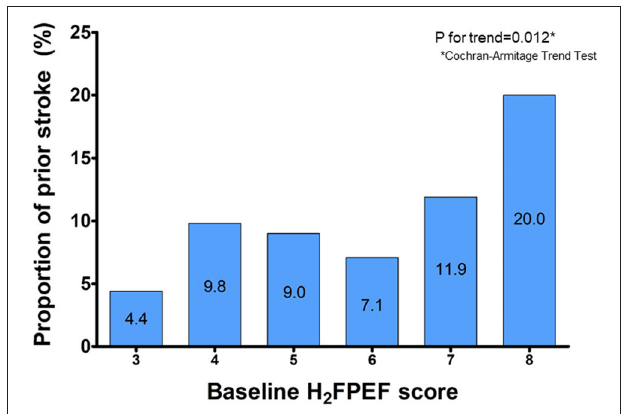
FIGURE 1 | The proportion of prior stroke according to the baseline H 2 FPEF scores.